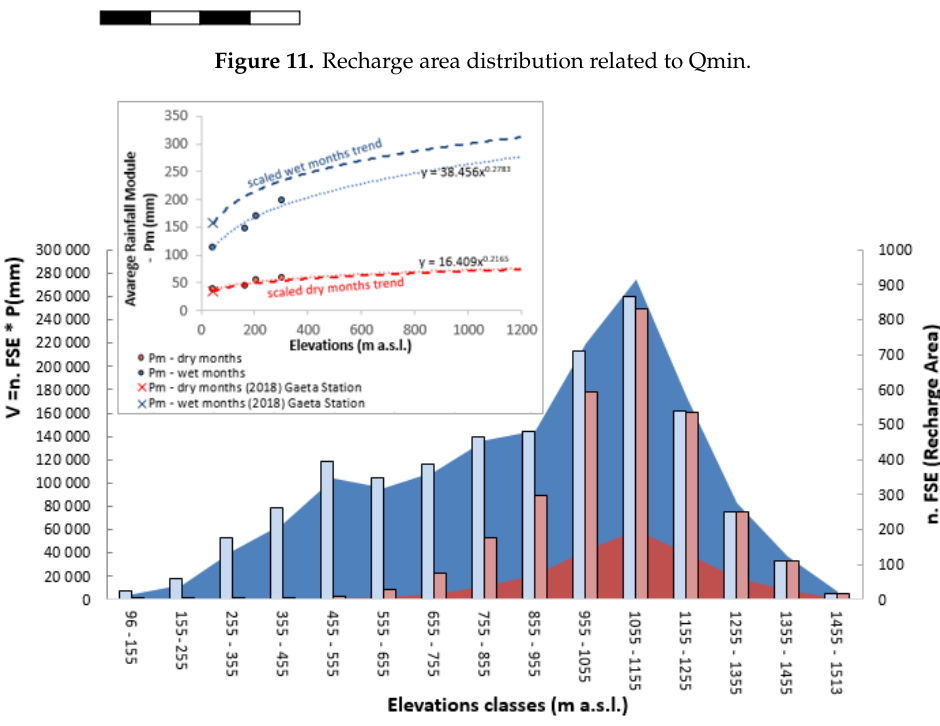
Figure 12. Comparison between recharge area and rainfall volumes (V max and V min ) relative to Q min and Q max (dry and wet periods).